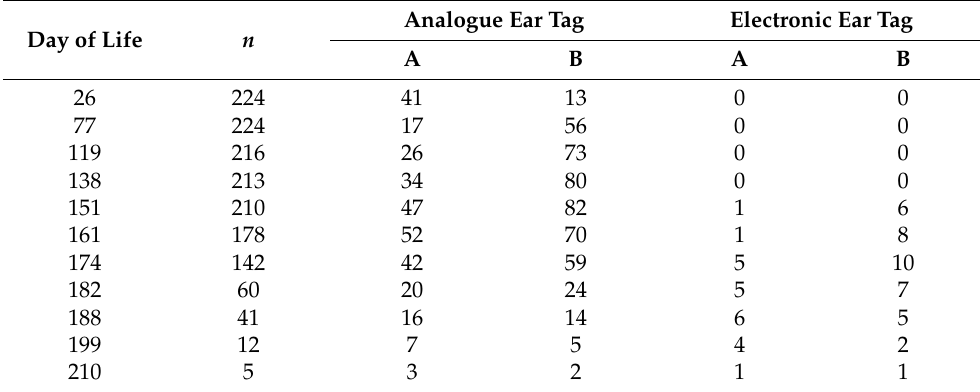
Table 10. Remaining analogue and electronic ear tags during the fattening